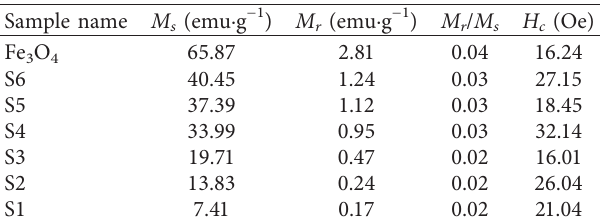
Figure 7: Magnetic hysteresis loops of S1 (a), S2 (b), S3 (c), S4 (d), S5 (e), S6 (f), and bare Fe Table 1: Magnetic properties of bare Fe 3 O 4 and various Fe 3 O 4 /PPy